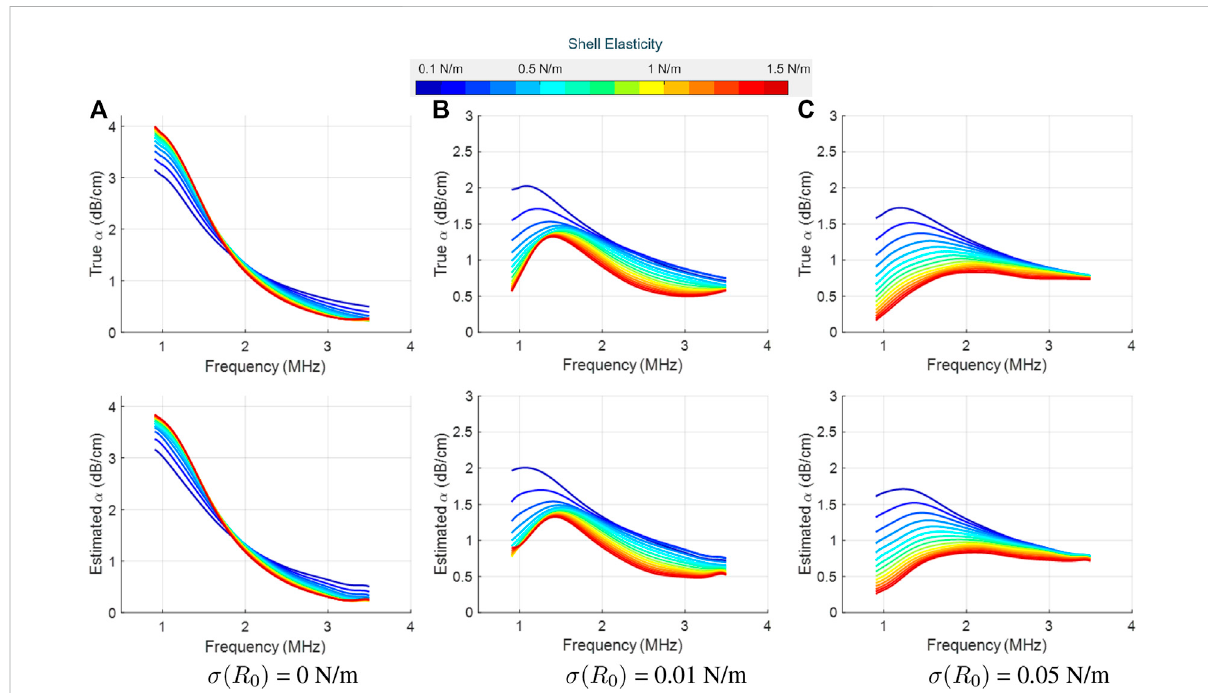
FIGURE 5 True (top row) and LLS estimated (bottom row) attenuation spectra for SonoVue with κ s = 10 × 10 − 9 kg/s at an acoustic pressure of 10 kPa, as a function of the shell elasticity (values shown in the colorbar). Column-wise, the plots are for three different initial surface tension values: (A) σ ( R 0 )